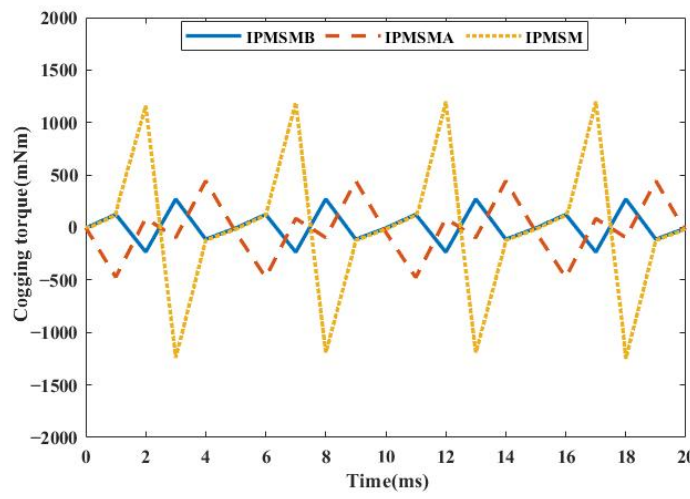
Figure 12. Cogging torque of three types of motors.